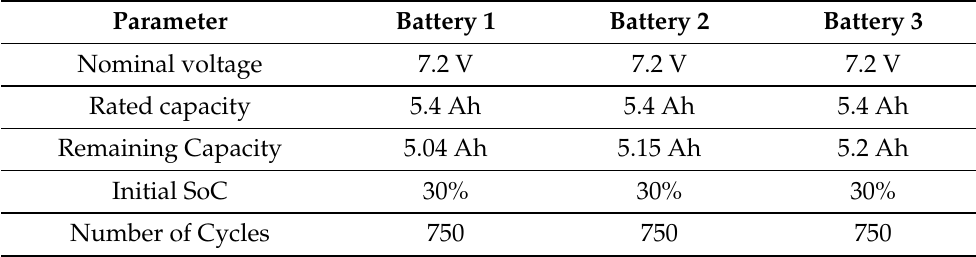
Table 9. Batteries parameters for Case